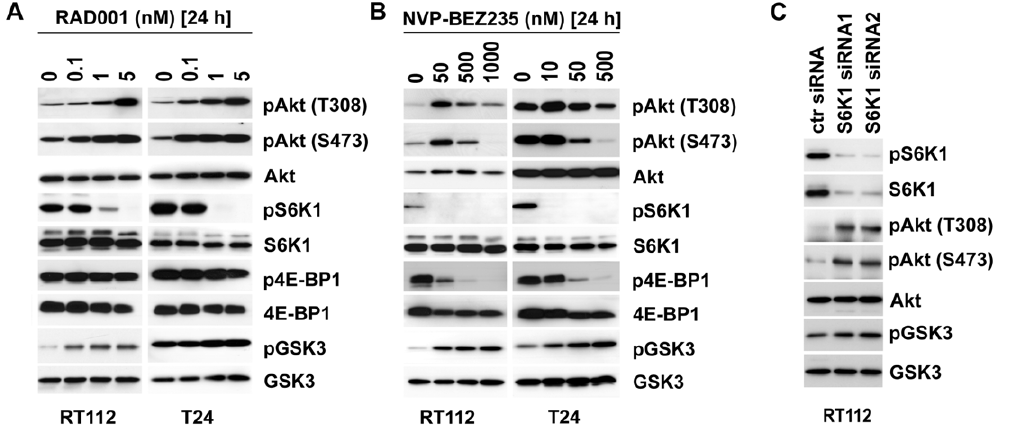
Figure 2. Long term treatment of cells with RAD001 and NVP-BEZ235 - S6K1 mediated activation of Akt. A, B: Effect of RAD001 or NVP- BEZ235 treatment over 24 hours on phosphorylation level of Akt, S6K1, 4E-BP1 and GSK3- b in RT112 and T24 cells. Whole cell lysates were applied to SDS-PAGE and blotted on PVDF membranes followed by immunoblots to detect expression and phosphorylation level of depicted proteins. The control (0) contained same concentration of DMSO as in samples with chemical compounds. C: RT112 cells were transfected with two independent S6K1 specific siRNA oligonucleotides and one random siRNA oligonucleotide as control (ctr siRNA). Three days after transfection, expression and phosphorylation level of S6K1, Akt and GSK3- b were analyzed in immunoblots.